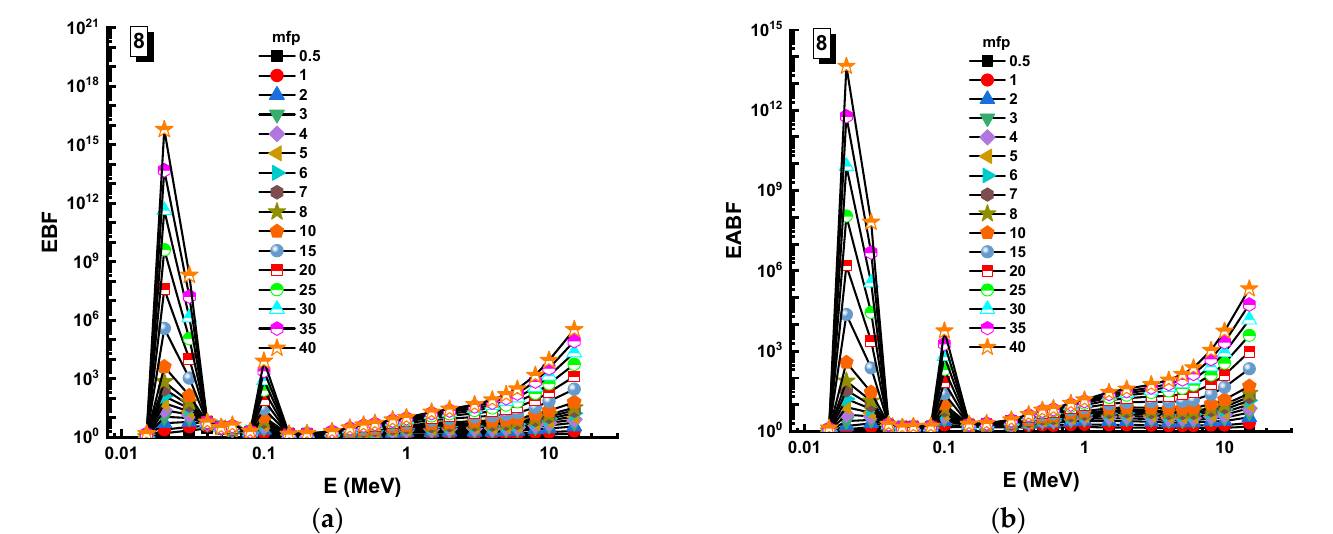
Figure 15. Variation of ( a ) EBF and ( b ) EABF against photon energy for Sample 8. Figure 16 shows variation of effective conductivity (C eff ) at 300 K (s/m) for all glasses. The results imply that as incoming photon energy rises, the effective thermal conductivity quickly falls, particularly in the low energy region, where the photoelectric effect dominates the photon–matter interaction [45,46]. However, Sample 8 was found to have the lowest C eff values of all the samples examined at low energies. The findings clearly reflect that Sample 8 has the minimum heat conductivity at all photon energies, which can also be considered another beneficial feature of Sample 8 in terms of radio-protective properties